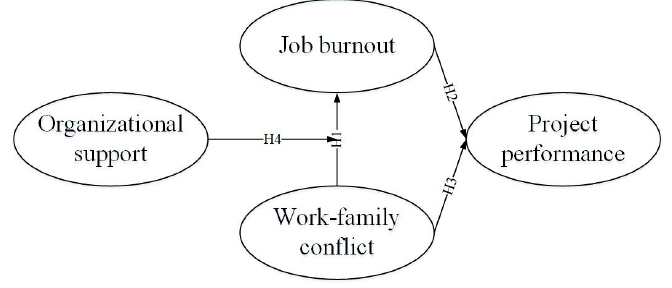
Figure 1. Theoretical model underlying empirical research